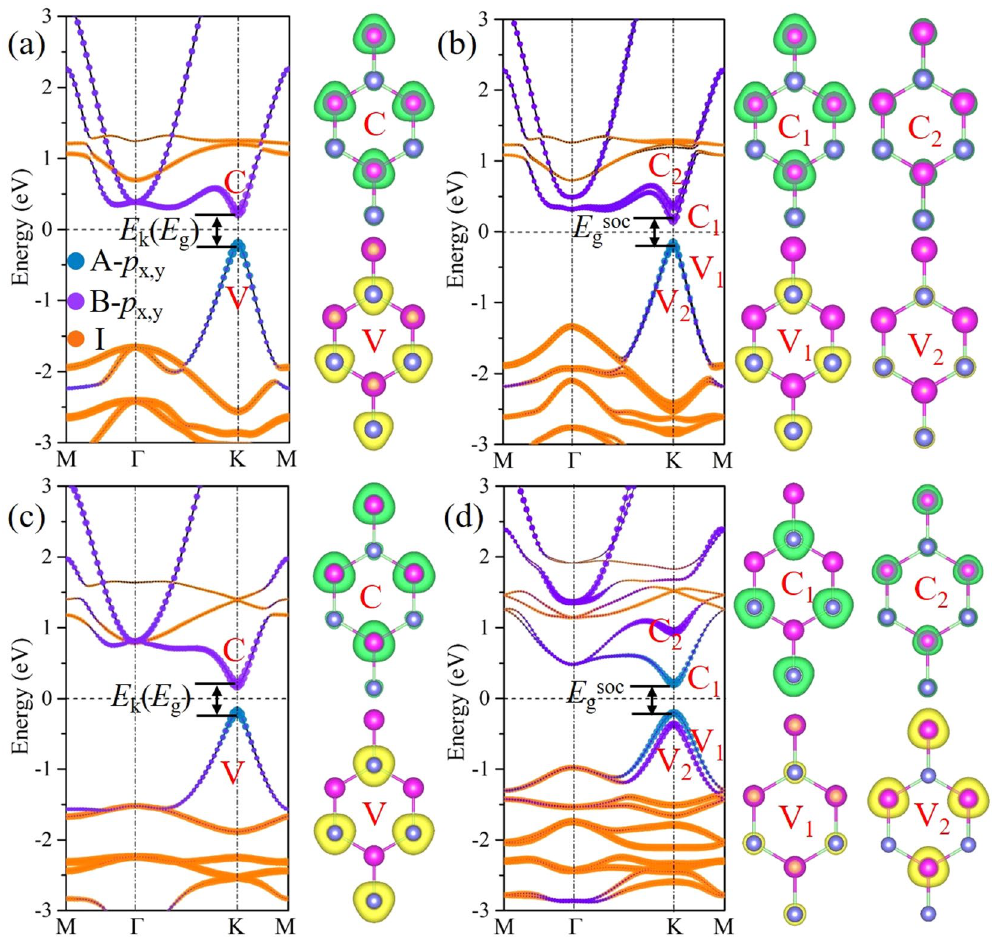
Figure 3. Orbital-resolved band structures and partial charge density of VBM and CBM. ( a ) PAsI 2 monolayer without SOC, ( b ) PAsI 2 monolayer with SOC, ( c ) SbBiI 2 monolayer without SOC and ( d ) SbBiI 2 monolayers with